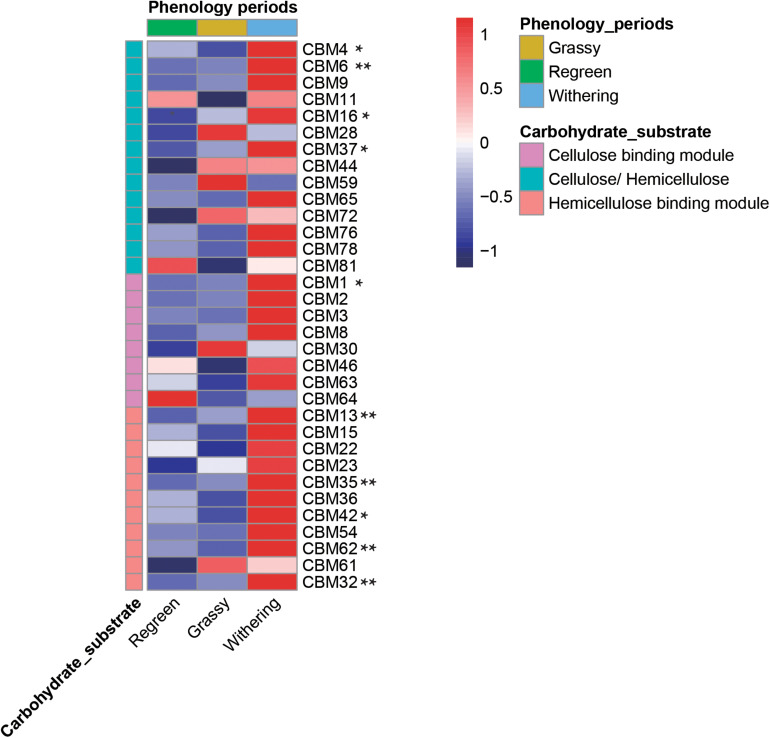
Comparison of CBMs linkd to various cellulose and hemicellulose in rumen metagenome samples during different phenological periods. Heatmap list the abundance of different CBMs. * meat there were significantly difference among groups (P < 0.05) and ** meant P < 0.01.